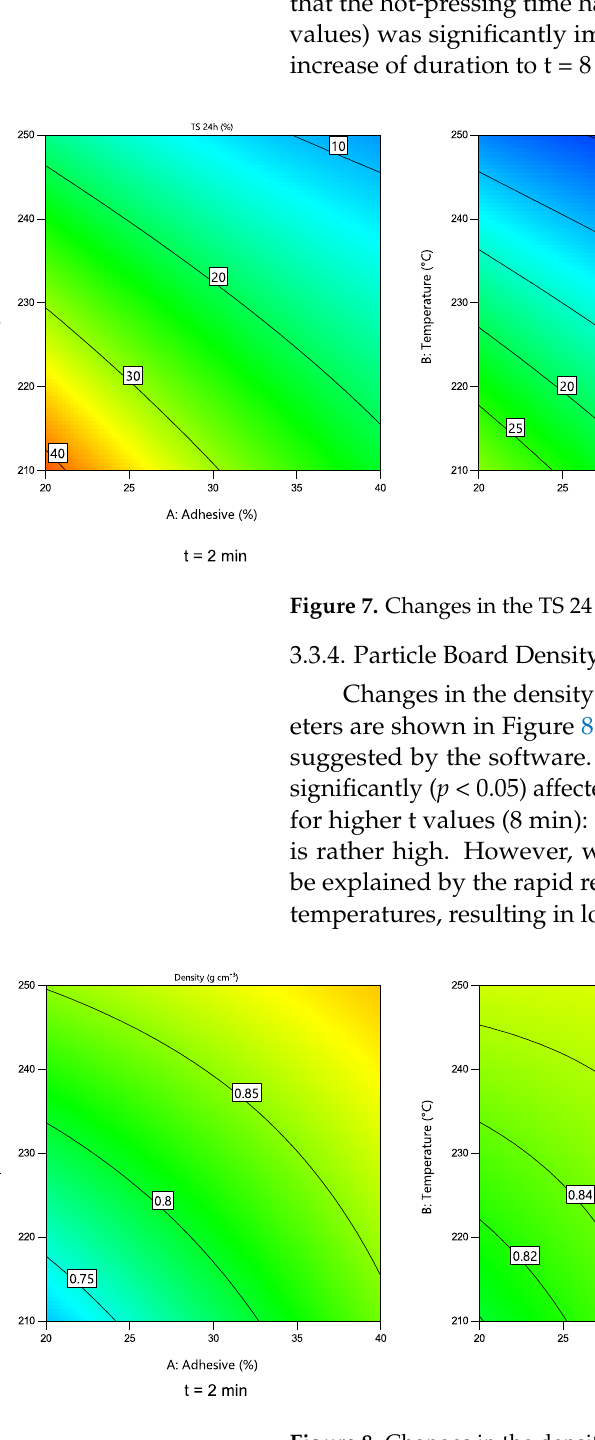
Table 10. Constraints for hot-pressing parameters and response values. Value Goal